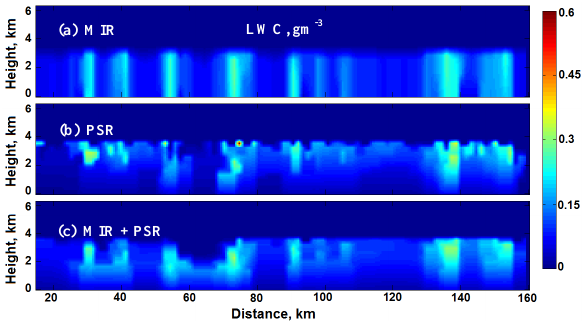
Figure 8: Retrieved cloud liquid water fields using the MIR data, the PSR data, and the combination of MIR and PSR data.